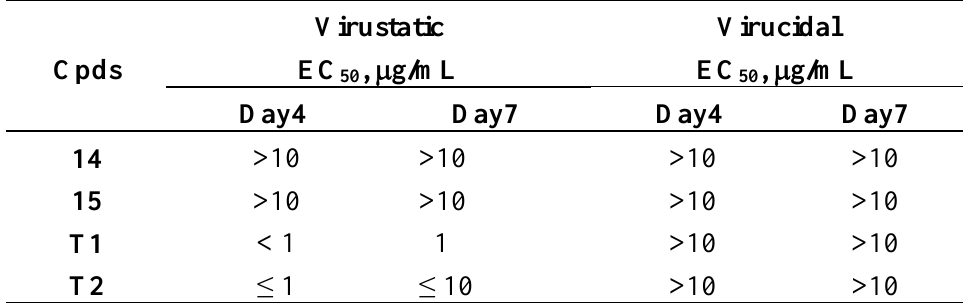
Table 2 . Virustatic and virucidal activities at 50% effective concentration ) against HIV-1 subtype E. (EC 50